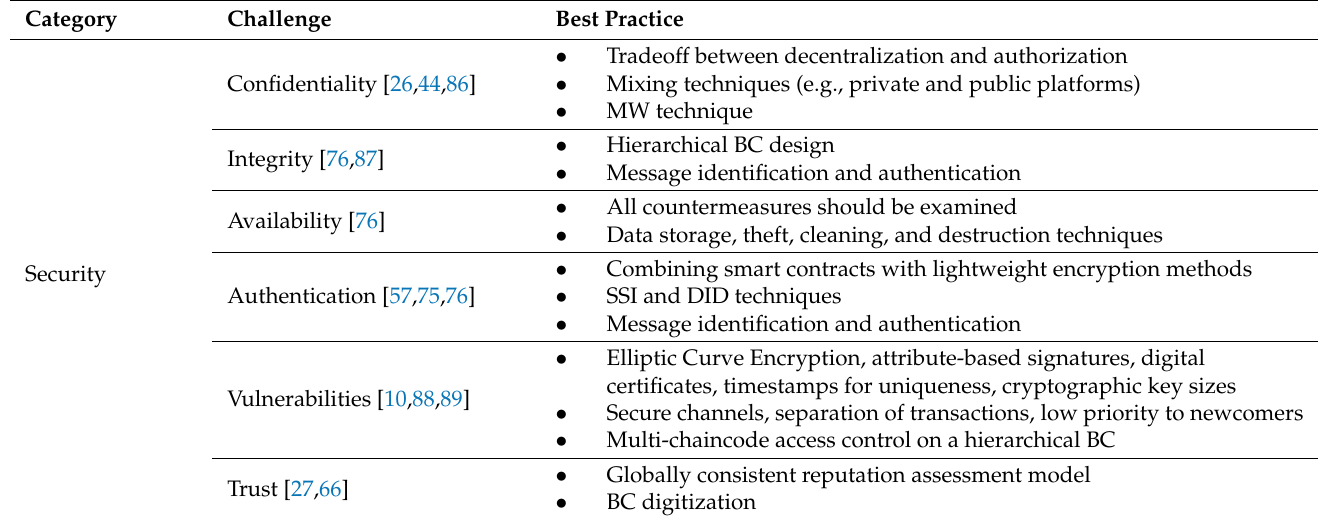
Table 6. Recommendations for reducing the negative impact of security